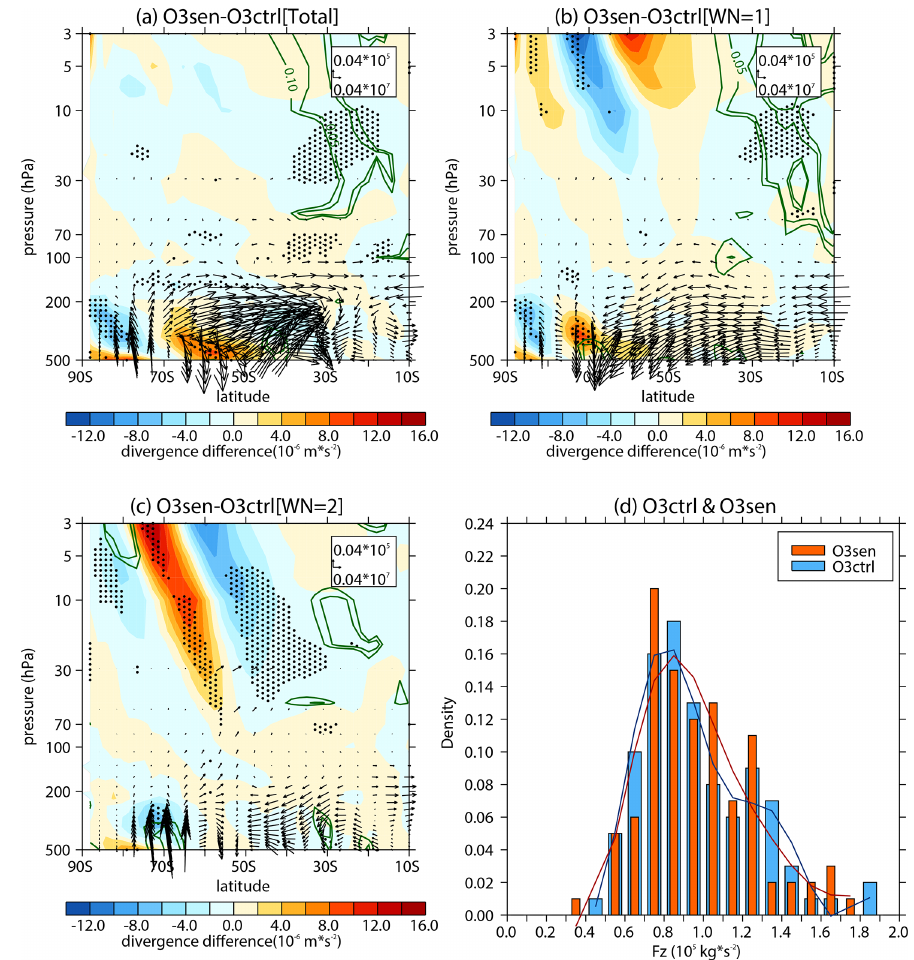
Figure 7. Differences in the (a) stratospheric E–P flux (arrows; units in horizontal and vertical components are 0.04 × 10 7 and 0.04 × 10 5 kgs − 2 , respectively) and its divergence (shading) with their (b) wave 1 component and (c) wave 2 component between the sensitivity experiment (O3sen) and the control experiment (O3ctrl). The stippled regions represent the mean differences in the E–P flux divergence significant at/above the 90% confidence level. The green contours from outside to inside (corresponding to p = 0.1 and 0.05) represent the mean differences in the vertical E–P flux significant at the 90% and 95% confidence levels, respectively. (d) Frequency dis- tributions (pillars; blue for O3ctrl and orange for O3sen) of vertical E–P flux (Fz; area weighted from 200 to 10hPa over 70–50 ◦ S) and its five-point low-pass filtered fitting curves (solid lines; blue for O3ctrl and red for O3sen) derived from 100 ensemble